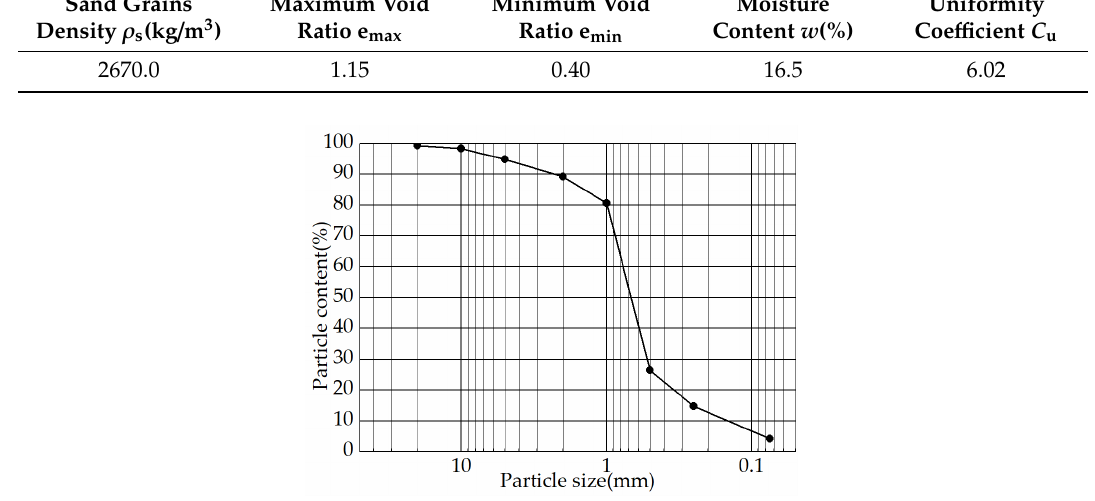
Figure 5. Grading curve of the soil sample.